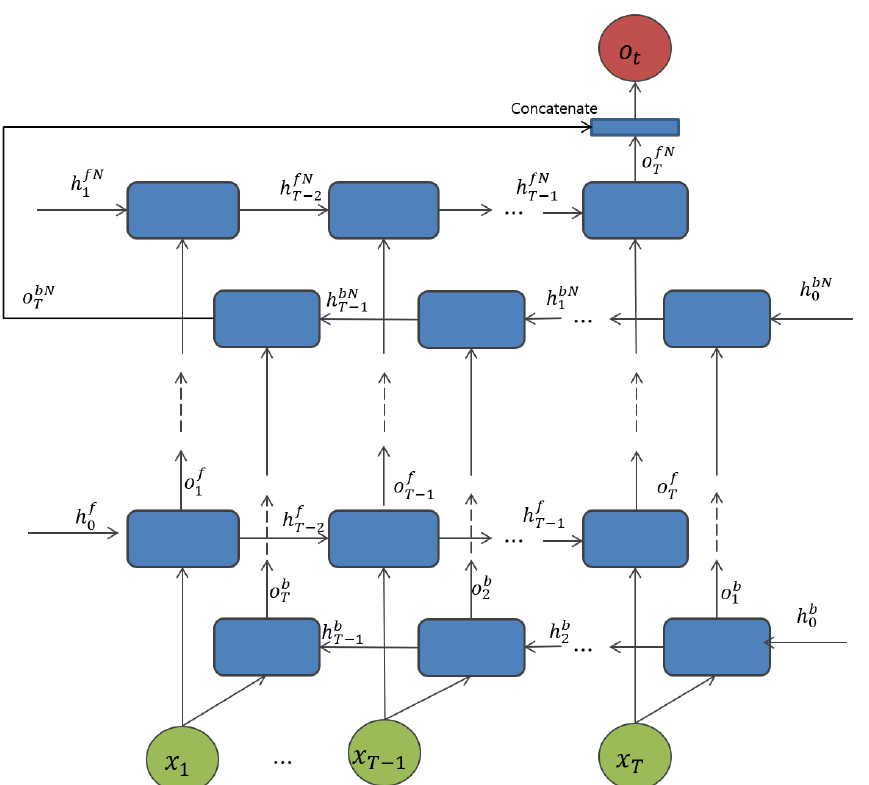
Figure 8. Proposed bi-directional RNN network for both LSTM and GRU cell unit.